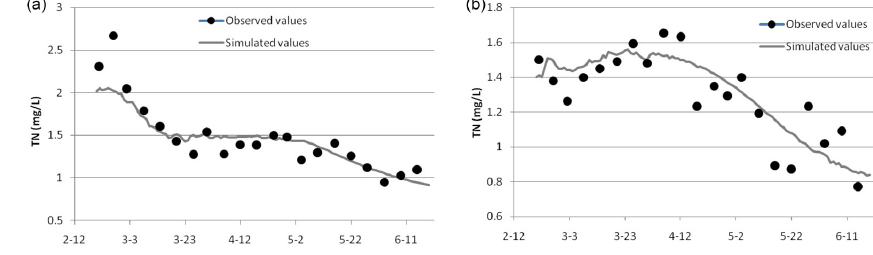
Figure 7. Calibration results for TN at sites 12 (a) and 11 (b) .